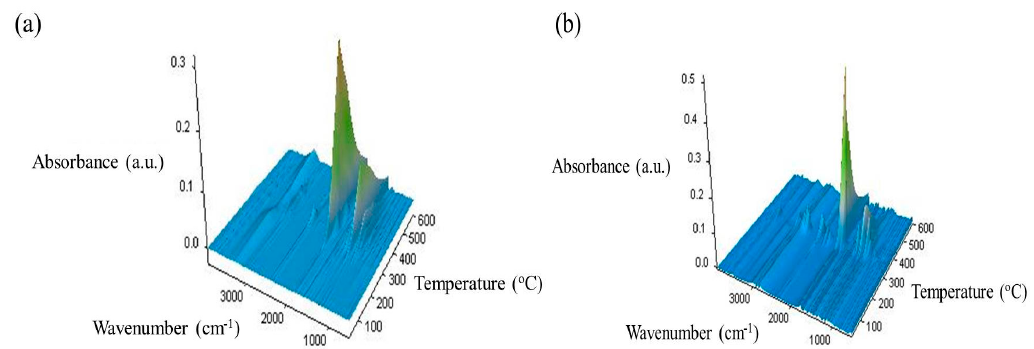
Figure 10. 3D-FTIR spectra of the volatile decomposition products resulting from the thermal degradation of PLA ( a ) and PLA/0.75R ( b ) samples.